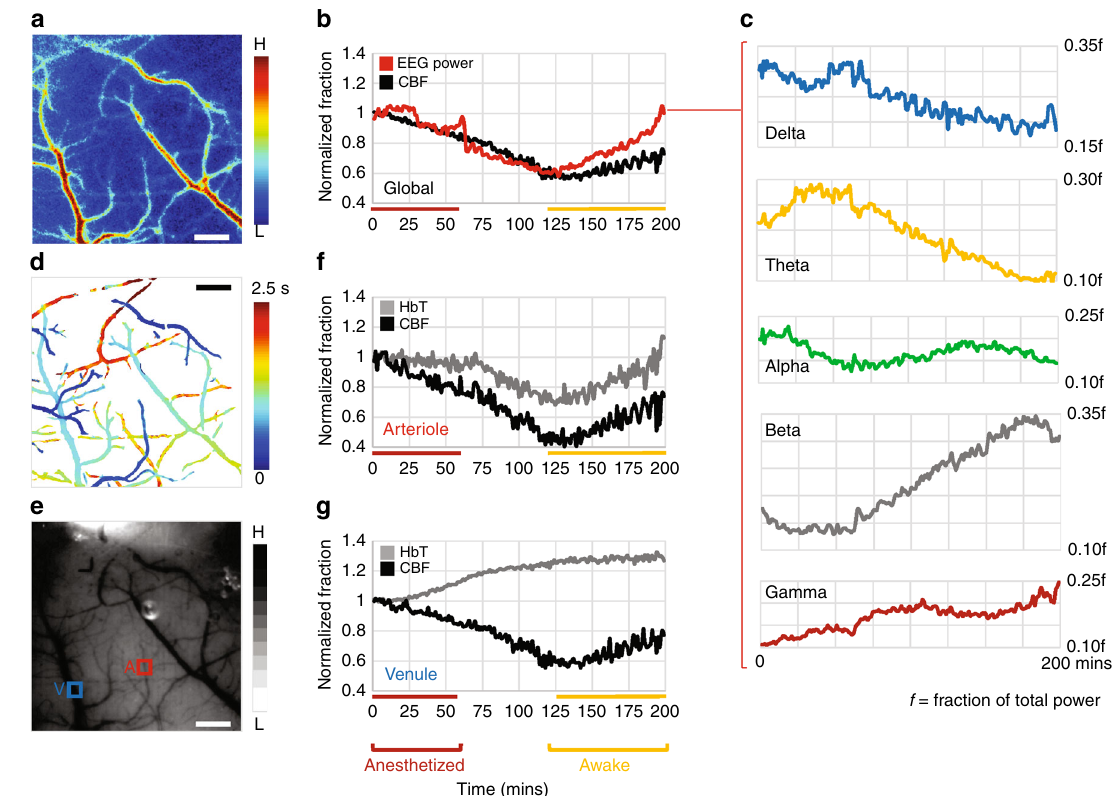
Fig. 5 Synchronized multi-contrast imaging and EEG during anesthesia recovery. a Map of the average CBF over the duration of the experiment. b Fluctuations in global EEG power and CBF are correlated. The anesthetized and awake phases are indicated by colored bars. c Plots of the power in EEG sub-bands showing how each varied during recovery from anesthesia. The post-script ‘ f ’ depicts the power of each sub-band as a fraction of the total EEG power. d Pseudocolored map illustrating the differences in arrival time of an intravenously injected fl uorescent tracer (dextran-FITC). Arrival times of the fl uorescent tracer are scaled for visualization purposes within the FoV. e IOS map acquired under green light illumination showing HbT absorption for the same FoV. An arteriole (A) and venule (V) are identi fi ed in the FoV. f , g Time-series illustrating HbT (i.e., CBV) and CBF fl uctuations within the arteriole and venule identi fi ed in e . Data presented is from a single animal and scale bar indicates 500 μ m. Also see Supplementary Table